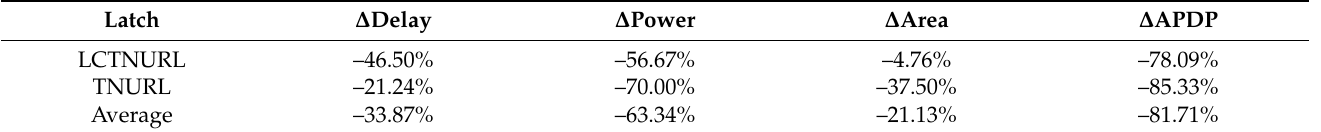
Table 3. Comparisons among TNU-recoverable latches.